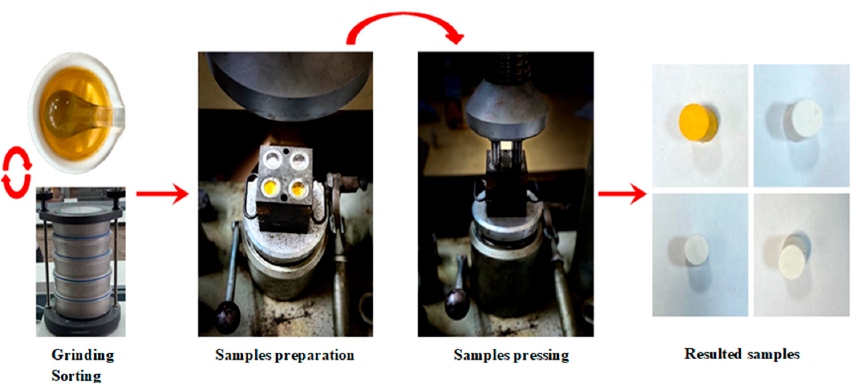
Figure 5. Technological process of PSAN cylindrical formulations.